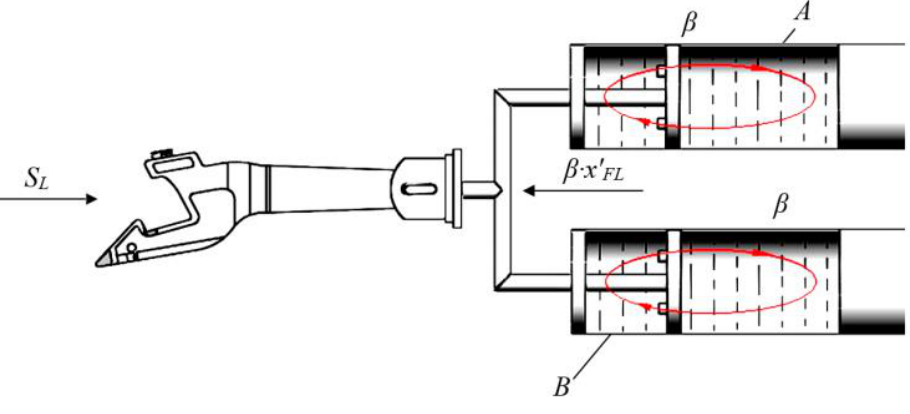
Figure 5. The operational diagram of the draft gear construct.